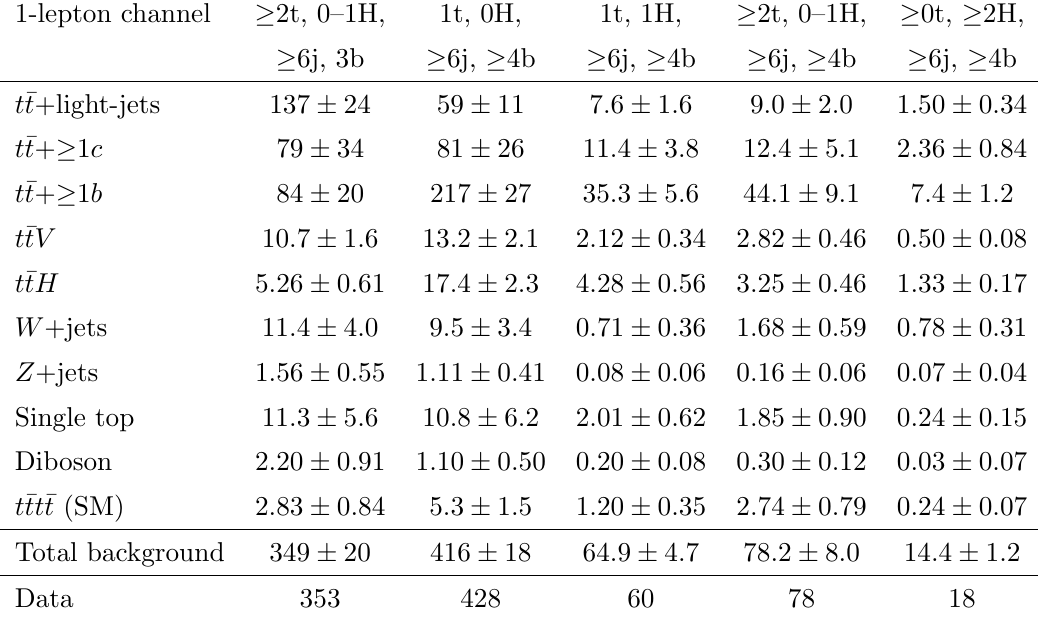
Table 6. Predicted and observed yields in the 1-lepton channel in (cid:12)ve of the most sensitive search regions (depending on the signal scenario) considered. The multijet background is considered negligible in these regions and thus not shown. The background prediction is shown after the combined (cid:12)t to data in the 0-lepton and 1-lepton channels under the background-only